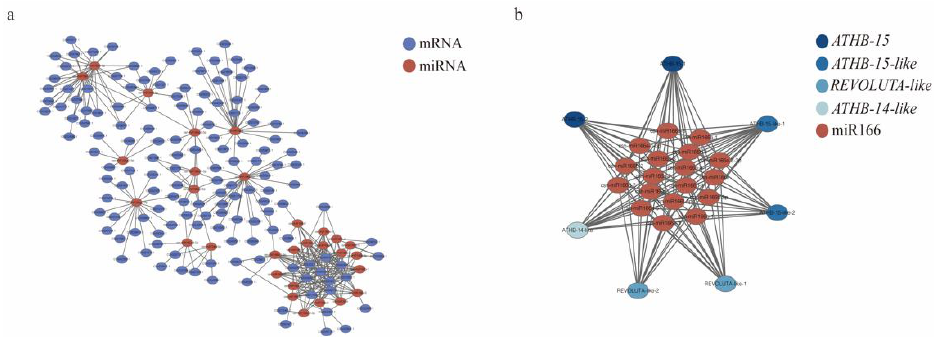
Figure 6. Regulatory network of the csn-miR66s and its targets in the tea plant. ( a ) Regulatory network of the csn-miR66s and its targets. ( b ) miRNA-mRNA modules related to the HD-ZIP III family.